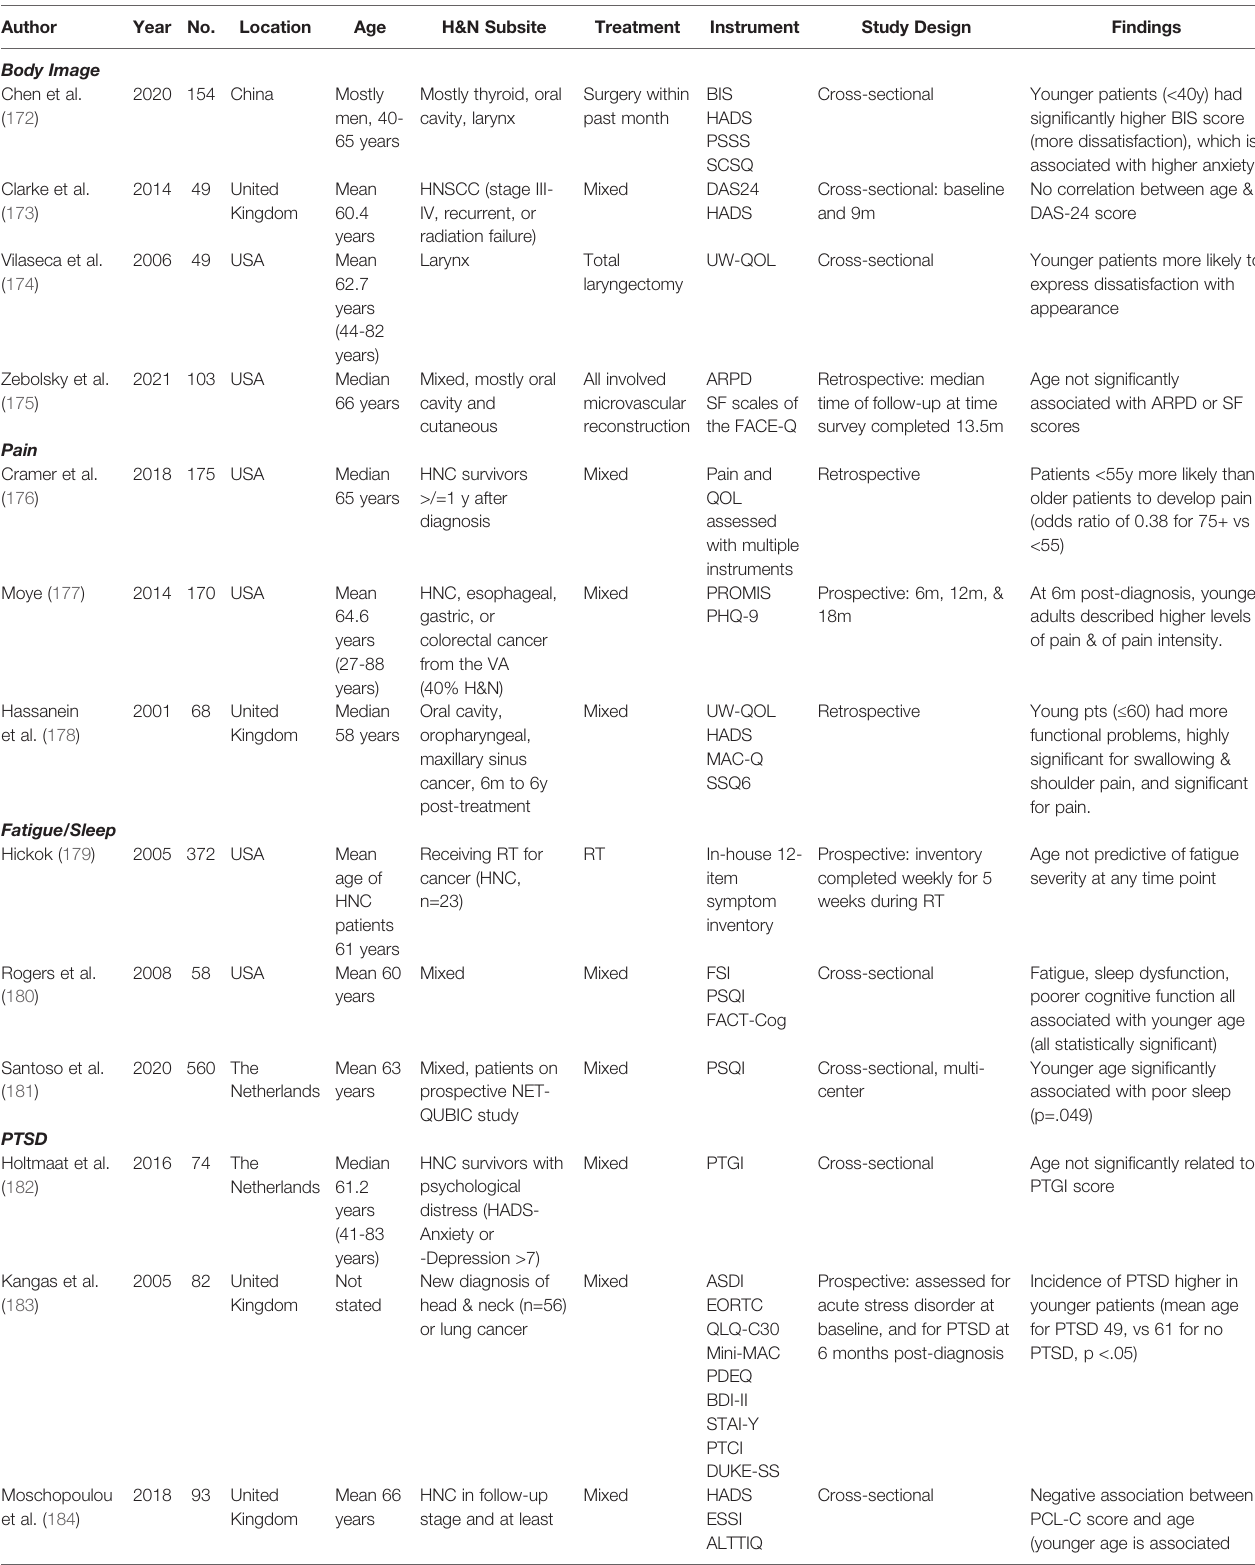
TABLE 10 | Studies reporting on body image, pain, fatigue/sleep, and post-traumatic